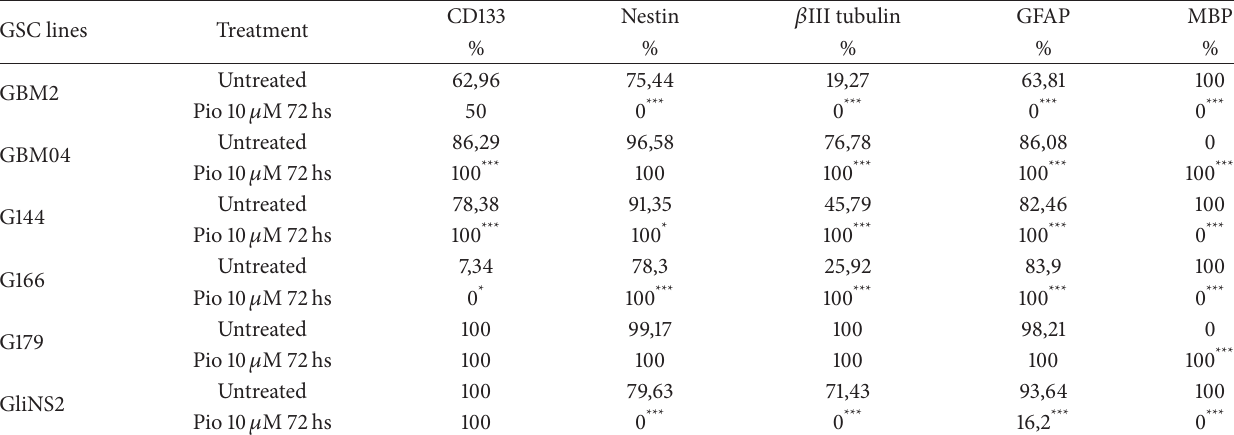
Table 1: Expression of stemness and differentiation markers in GSC lines in response to Pio treatment. GSC lines